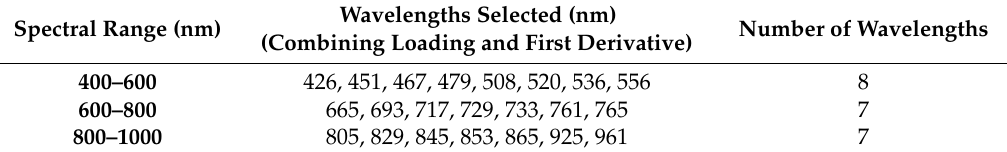
Figure 9. First derivative of spectra. Table 3. Selected optimal wavelength.